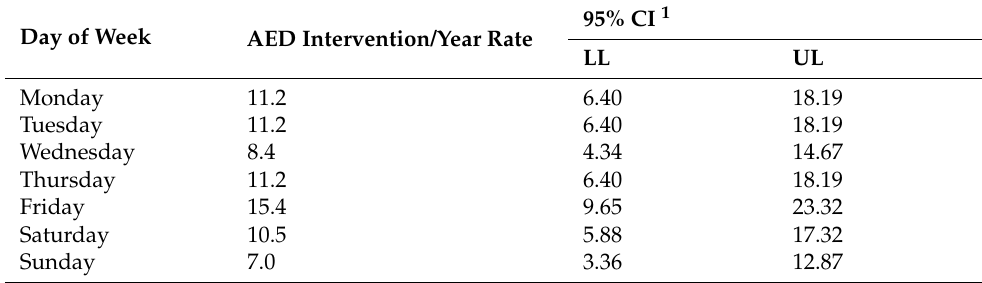
Table 6. Frequency of AED interventions by day of the week. Day of